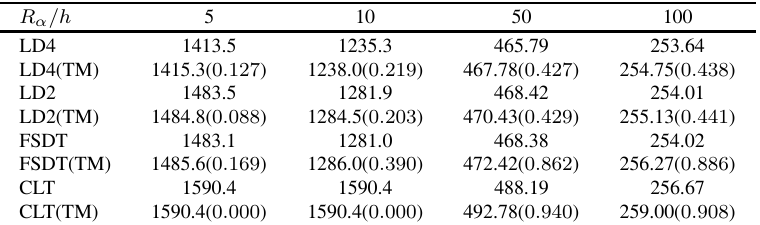
Table 3 Free vibrations of one-layered isotropic shell: fundamental frequency f in Hz for m = n